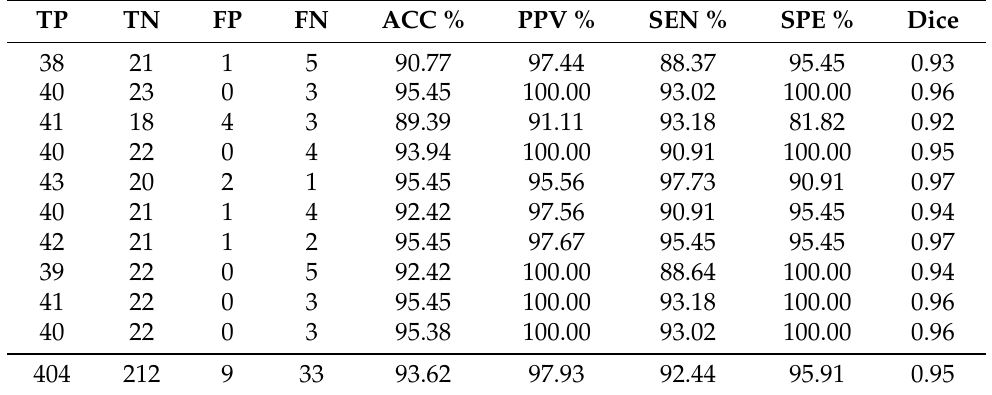
Table 4. SVM with RBF kernel. The first 10 rows in the table document the performance results for each individual fold. The last row states the averaged performance results.